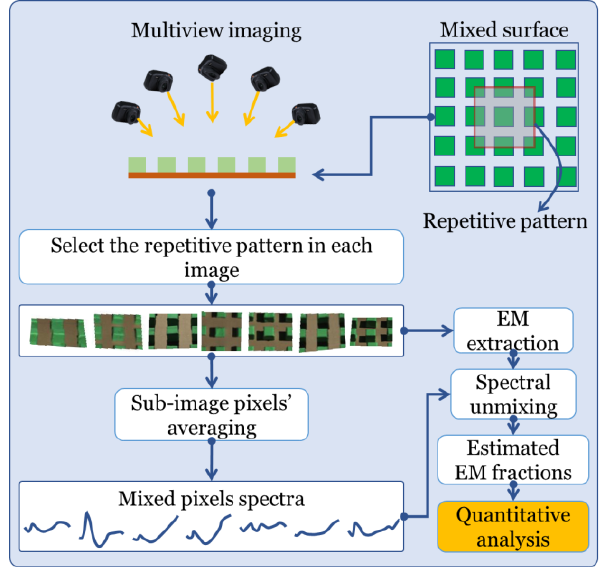
Figure 3 . An overview of the study’s workflow